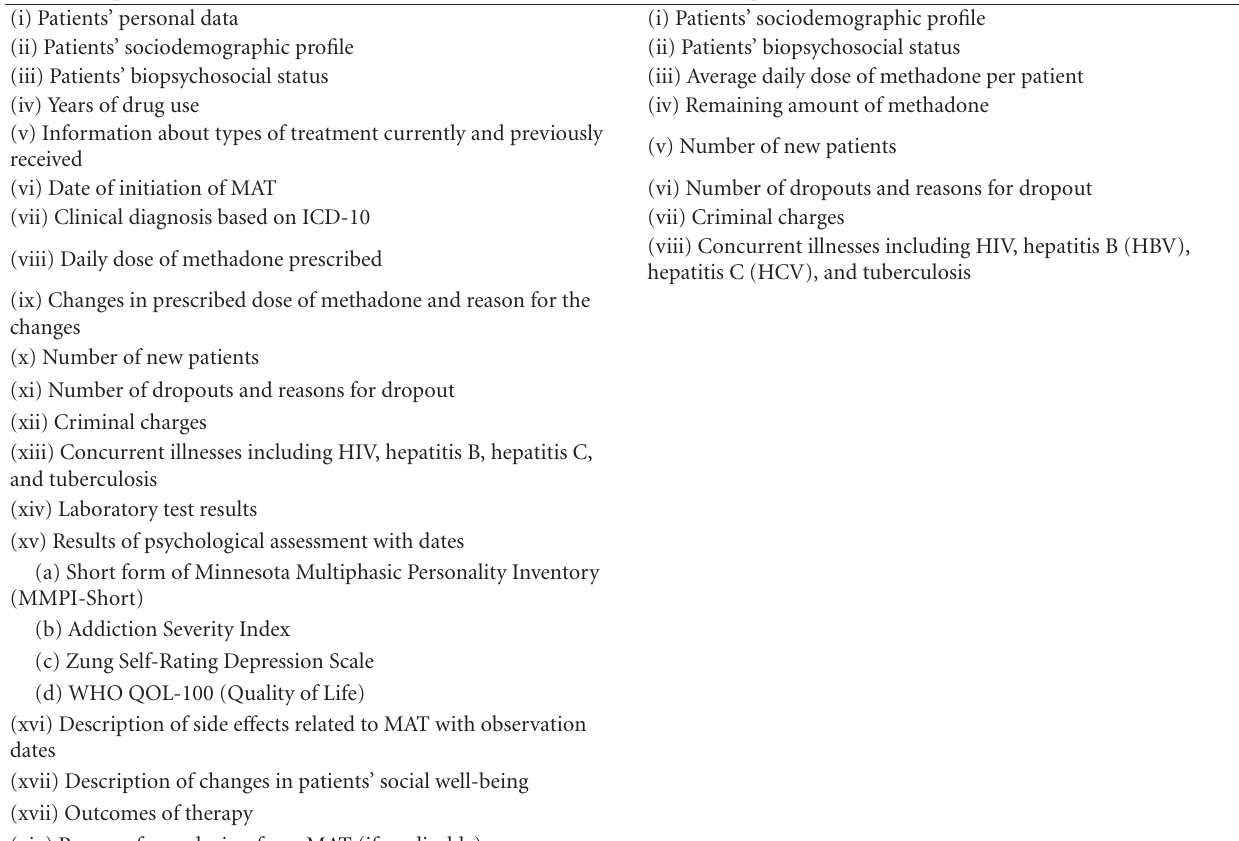
Table 2: Variables reported by medication-assisted treatment sites in Kazakhstan to the Republican Applied Research Center for Medicosocial Problems of Drug Addiction (RARC) and Republican AIDS Center (RAC). Variables reported to the RARC Variables reported to the